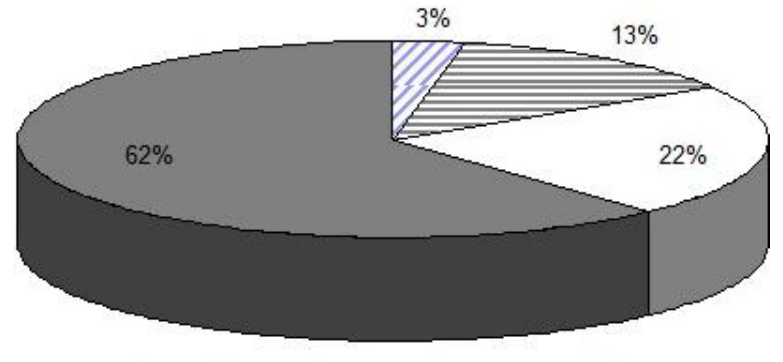
Figure 1. The level of knowledge on waterborne diseases in Vhembe